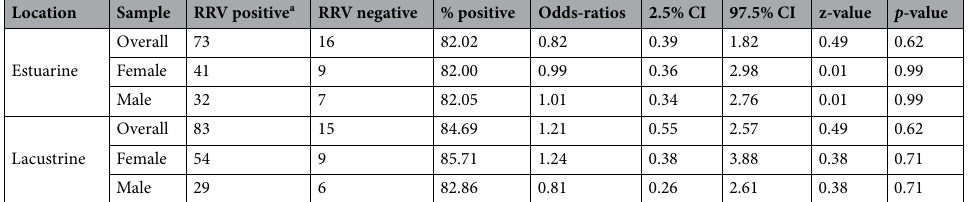
Table 2. Seroprevalence of Ross River virus (RRV) in koalas residing in urban coastal lacustrine and estuarine environments. Comparison of seroprevalence rates between environments was performed using data only for animals for which their location could be confirmed (n = 187) after accounting for relocated individuals and animals with too few position locations (n < 5) to confirm their assignment to a particular environment. a An animal sampled multiple times was considered seropositive if the animal returned a positive test result during any individual sampling event.